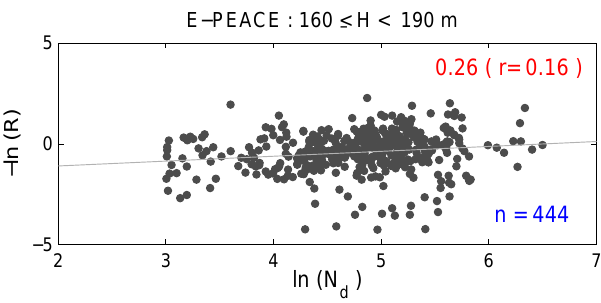
Figure 3. Examples of scatterplots used to calculate precipitation susceptibility S o (i.e., the slope) for E-PEACE. Black dots indicate data points for an H interval between 160 and 190m. Numbers on the bottom right (blue) indicate the total number of data used. S o and linear coefficient ( r ) values are shown in the upper right cor- ner. Precipitation, R , increases downward in y ordinate, and N d in- creases toward the right direction in x